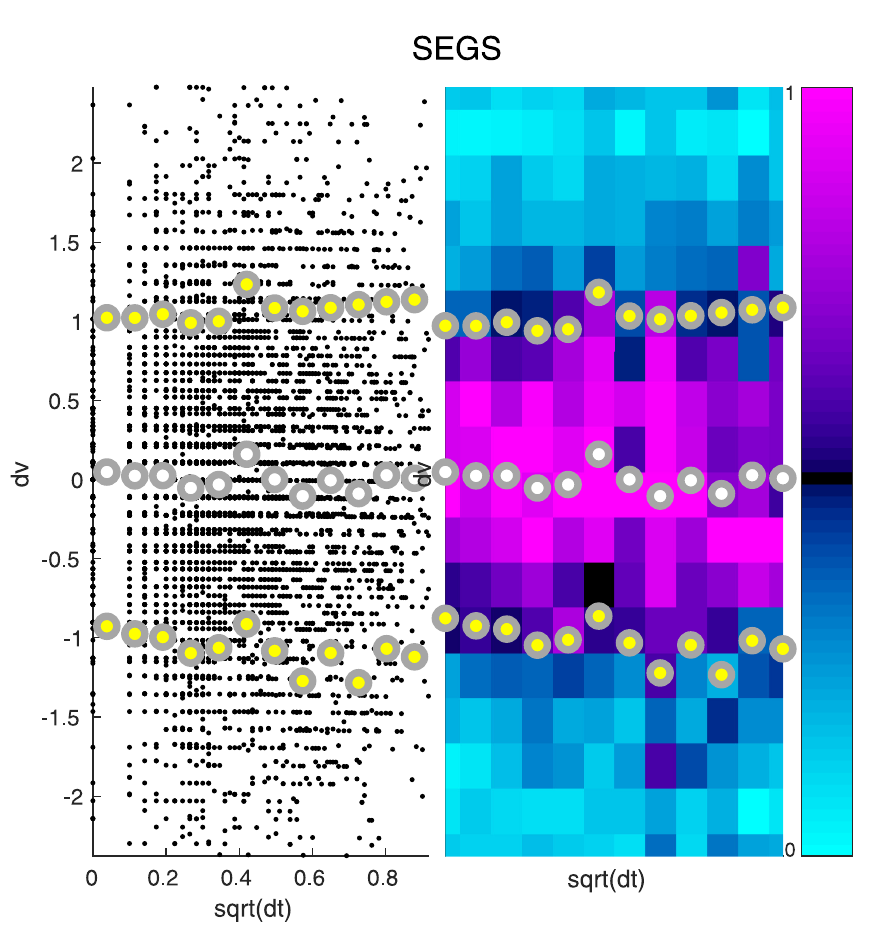
Fig 3. Increments of Segmented Neutrophils. Here we illustrate the distribution of increments associated with Segmented Neutrophils (SEGS). The format for this figure is the same as Fig